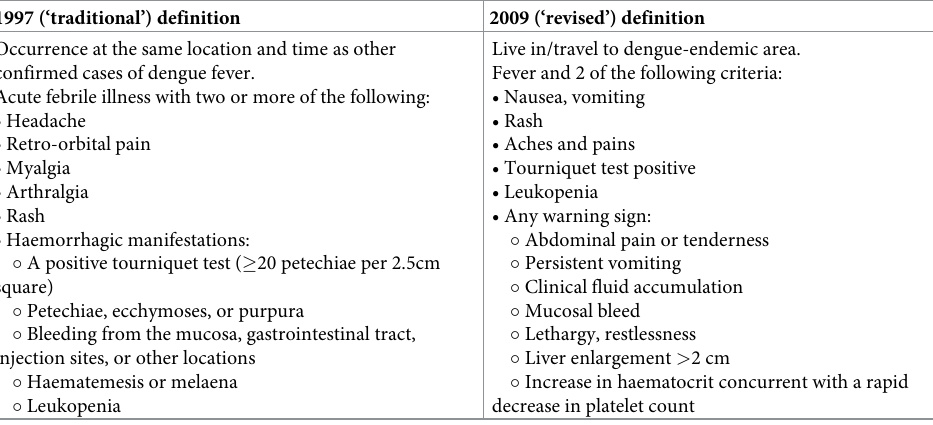
Table 2. Traditional (1997) and revised (2009) WHO clinical definitions of dengue